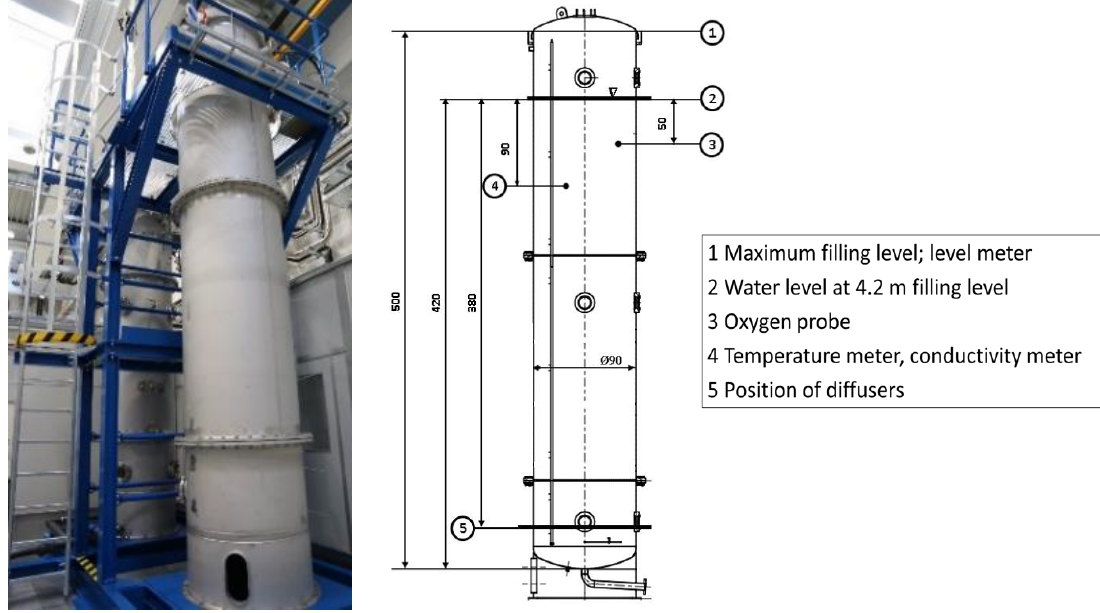
Figure 1. Test facility for oxygen absorption measurements: ( left ) photograph of the DN 900 activated sludge columns, ( right ) dimensions (in cm) and designation of instruments.